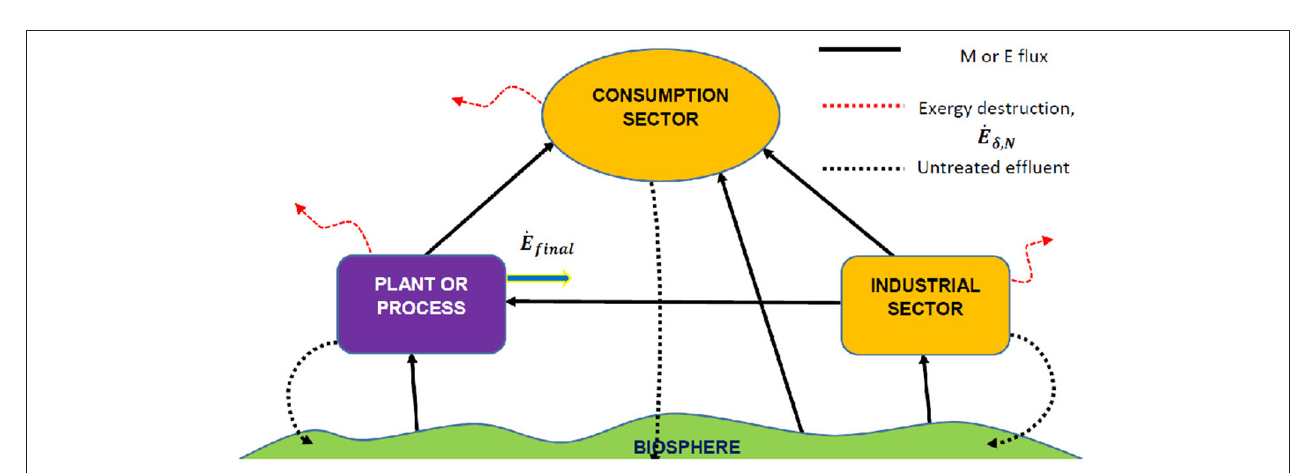
FIGURE 8 | The control volume for a Thermo-Ecological (TEA) analysis.